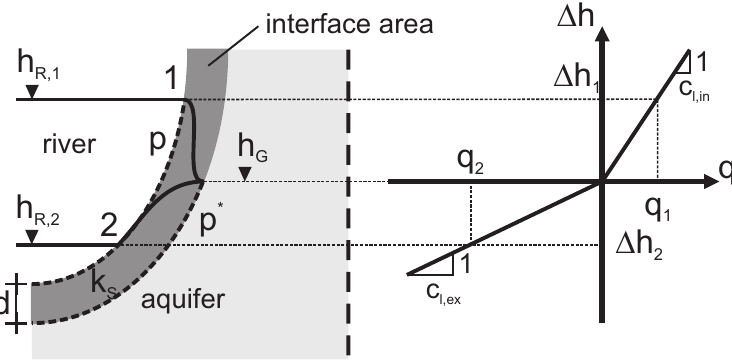
Figure 1. Schematic view of two different flow conditions in a cross-section of an idealized stream and the corresponding leakage function (head difference ∆ h over the exchange rate q , c and c denote the leakage coefficient for infiltration and exfiltration, respectively). l , in l , ex River stage h gives a positive head difference and leads to infiltration, and the river stage R , 1 below groundwater level h leads to exfiltration (modified and extended after R , 2